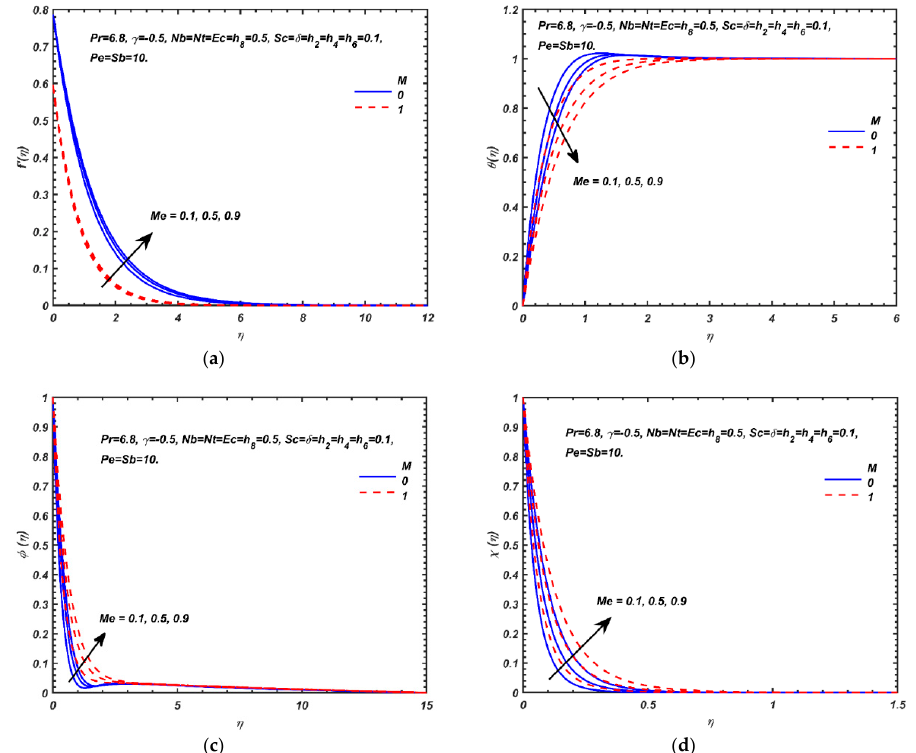
Figure 6. Effects M and Me on the dimensionless ( a ) velocity, ( b ) temperature, ( c ) nanoparticle volume fraction and ( d ) micro-organism density number function.